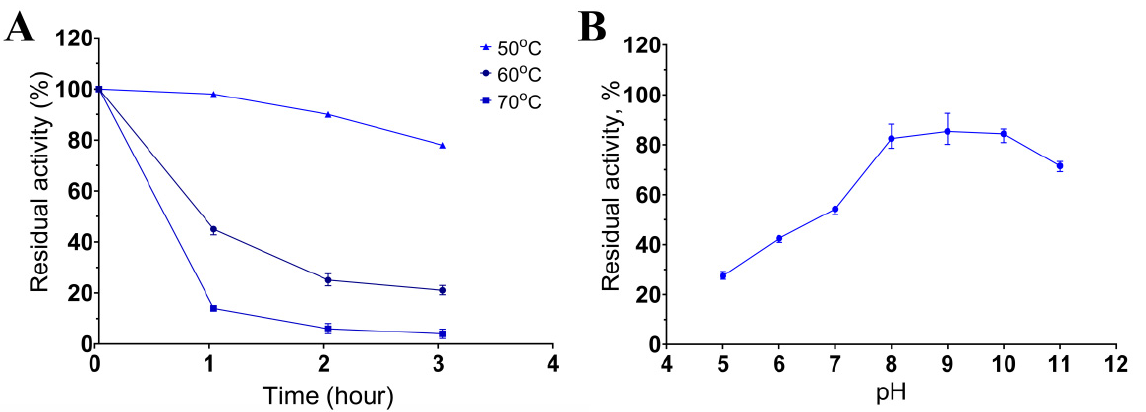
Figure 4. The influence of temperature ( A ) and pH ( B ) on keratinase stability. Values shown in ( A ) and ( B ) (mean ± standard deviation [SD]) are representative data obtained in triplicate assays of the enzymatic extract from Bacillus sp. A5.3.